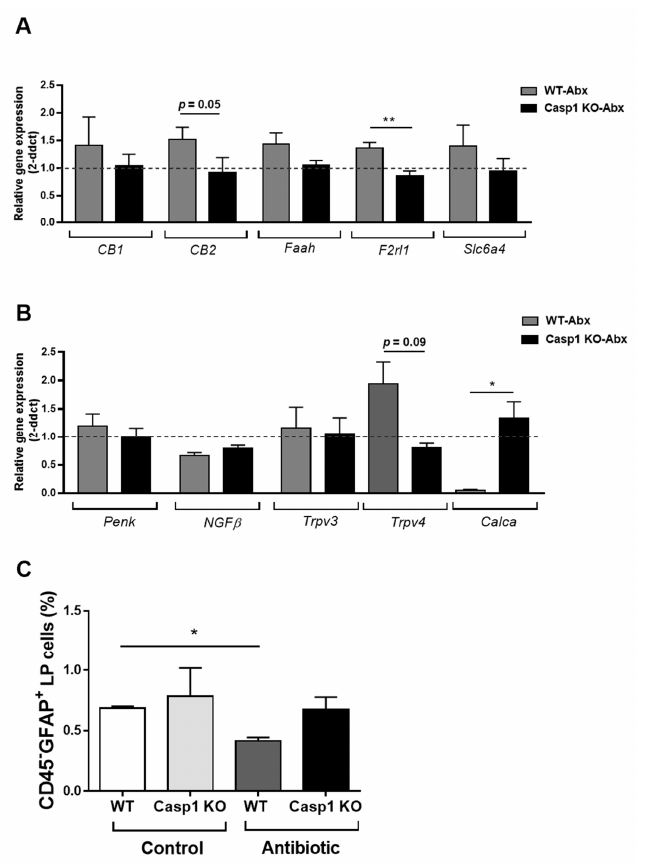
Figure 4. Representative RT-qPCR expression of colon nociceptive markers; ( A ) the endocannabinoid system ( CB1, CB2 and Faah ), the protease-activated receptor 2 (PAR2, Fr2l1 ) and the serotonin transporter ( Scl6a4 ); ( B ) the opioid peptide pro-enkephalin ( Penk ), the neurothrophin (NGF β ), the vanilloid system (transient receptor potential, Trpv3 and Trpv4 ) and calcitonin-related polypeptide alpha ( Calca ). Data are mean (SEM). n = 7–9/group. *: p <0.05, **: p < 0.001. Abx: antibiotic. Dashed line indicates background value of 1 of WT and Casp1 KO-control groups. ( C ) Colonic lamina propria (LP) cells isolated from control and antibiotic-treated WT and Casp1 KO mice and stained with CD45 and GFAP. Bars represent the percentage of the indicated cell population. Representative figure of two individual experiments. Data are mean (SD). n = 4/group. *: p < 0.05.